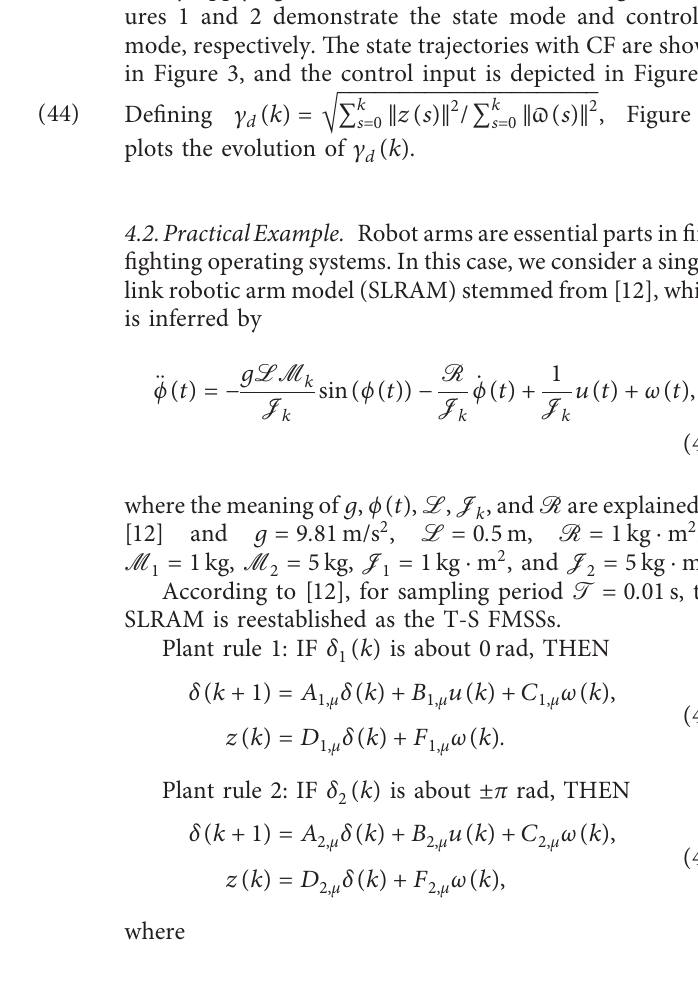
plots the evolution of c d ( k )